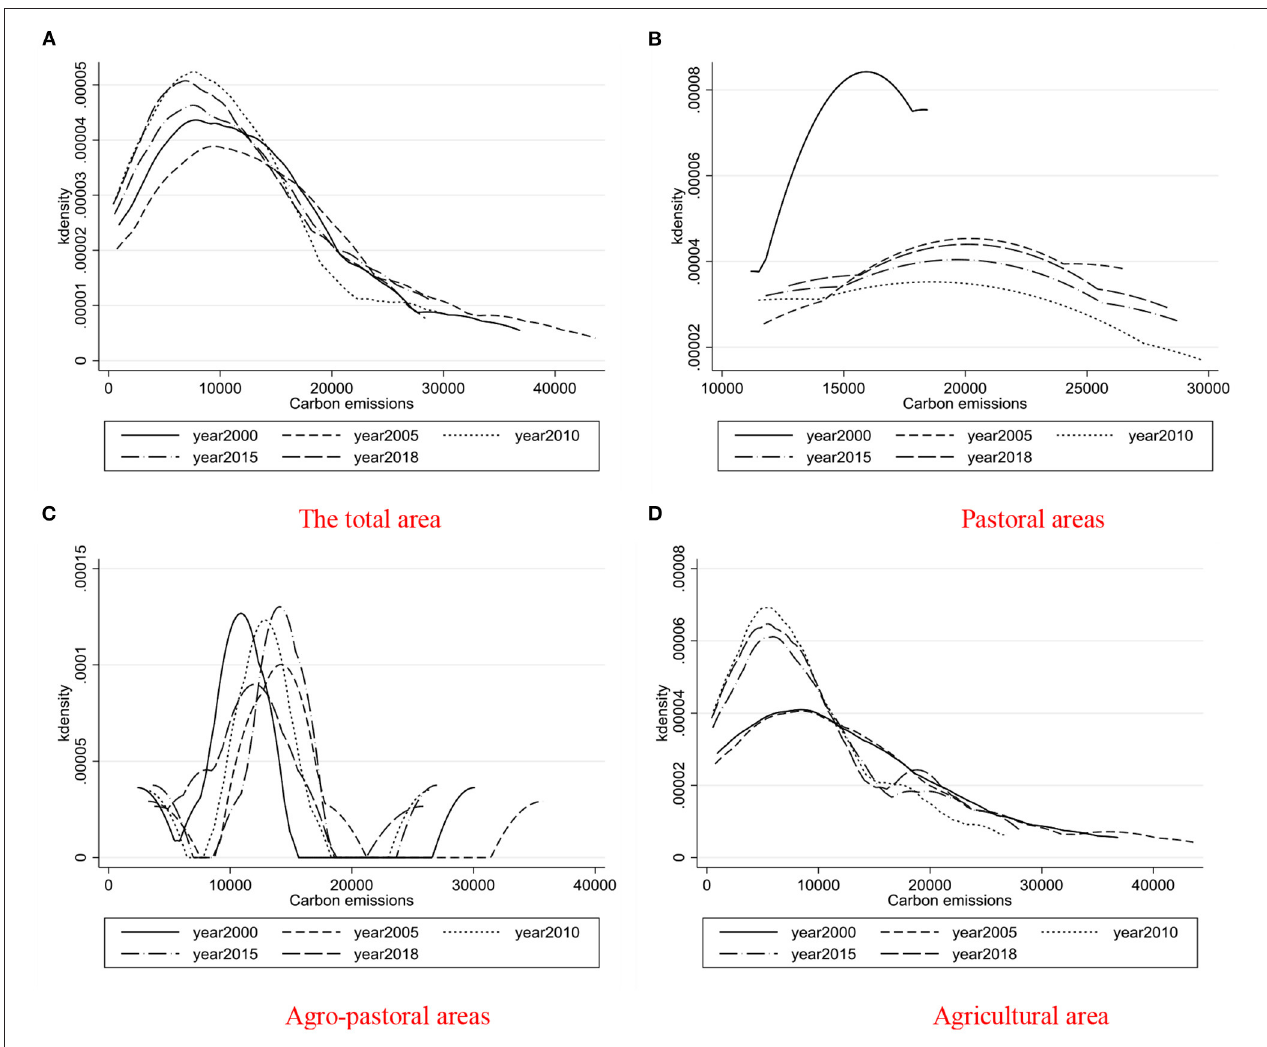
FIGURE 4 | Dynamic changes of carbon emissions of animal husbandry result. (A) The total area. (B) Pastoral areas. (C) Agro-pastoral areas. (D) Agricultural